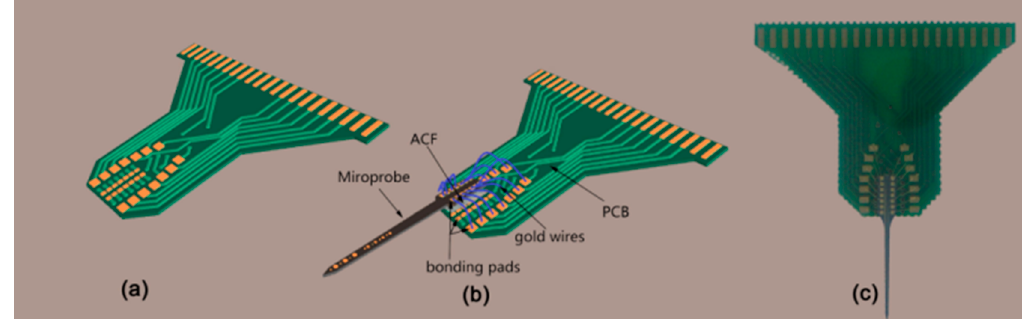
Figure 5. ( a ) Schematic diagram of the specifically designed PCB; ( b ) assembly scheme for connecting the double-sided microelectrode array with PCB; ( c ) optical image of schemed microelectrode array.